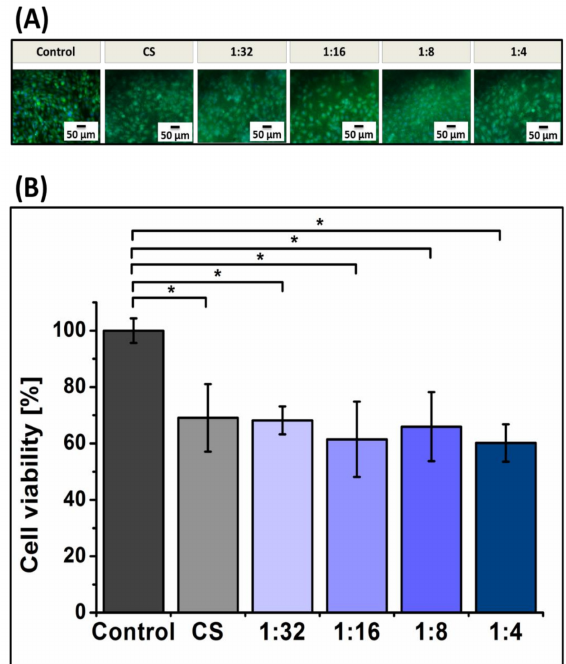
Figure 8. ( A ) Fluorescence microscope images, showing the results of Calcein-DAPI staining of MG-63 cells after 24 h of culture on CS and Ga (III)-CS complex coatings with di ff erent Ga (III) concentrations. ( B ) Cell viability of osteoblast-like cells (MG-63) cultured on CS and Ga (III)-CS complex coatings with di ff erent Ga (III) concentrations after 24 h of incubation. Tissue culture plate was used as a control. Asterisks (*) denote significant di ff erences ( p <